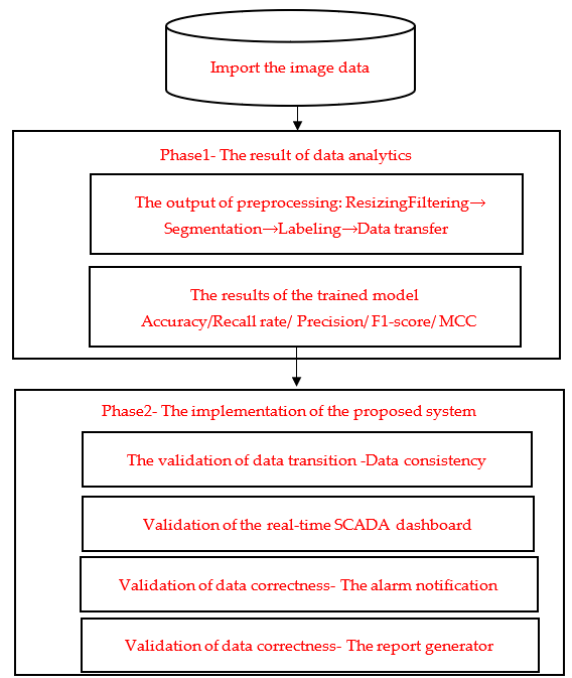
Figure 9. The fl owchart of the experiment.